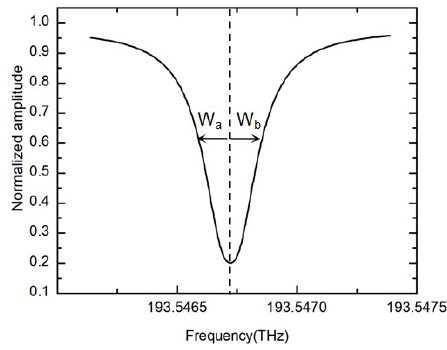
Figure 7. The definition of the resonance asymmetry degree.